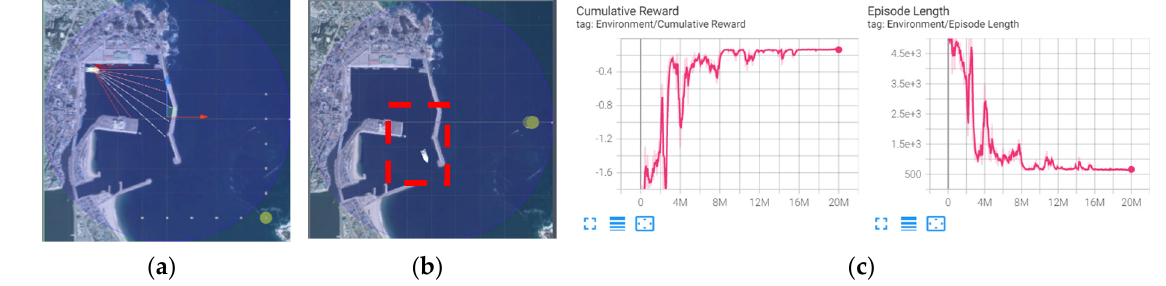
Figure 6. ( a ) Randomly selected destination set for the autonomous ship to learn departure (right bottom). Coordinates to a destination are given in the GPS. ( b ) Autonomous navigation after the completion of learning. A sea route is selected through a greedy method. The red rectangle in the experiment is the concerned zone, where human-defined navigation rules shall be applied because of the frequent harbor entry and departure. ( c ) Convergence of learning from approximately eight million steps, stabilizing after 16 million steps (approximately one learning scenario—no. of learning steps/800).